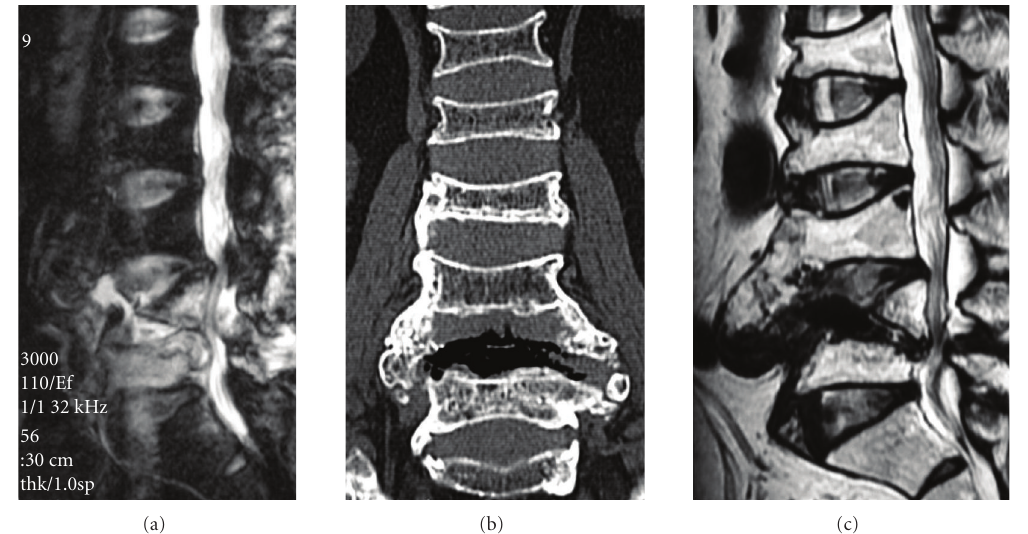
Figure 1: Imaging studies for Case 1. (a) Preoperative lumbar spine MRI showing sagittal T2-weighted image. Destruction of the L4 vertebral body and an abscess are evident. (b) Postoperative lumbar spine MRI showing sagittal T2-weighted image. Normalization of signal intensity in vertebral bodies and disappearance of abscess are observed. (c) Postoperative CT showing callus formation bridging the vertebral bodies around the L4/5 intervertebral